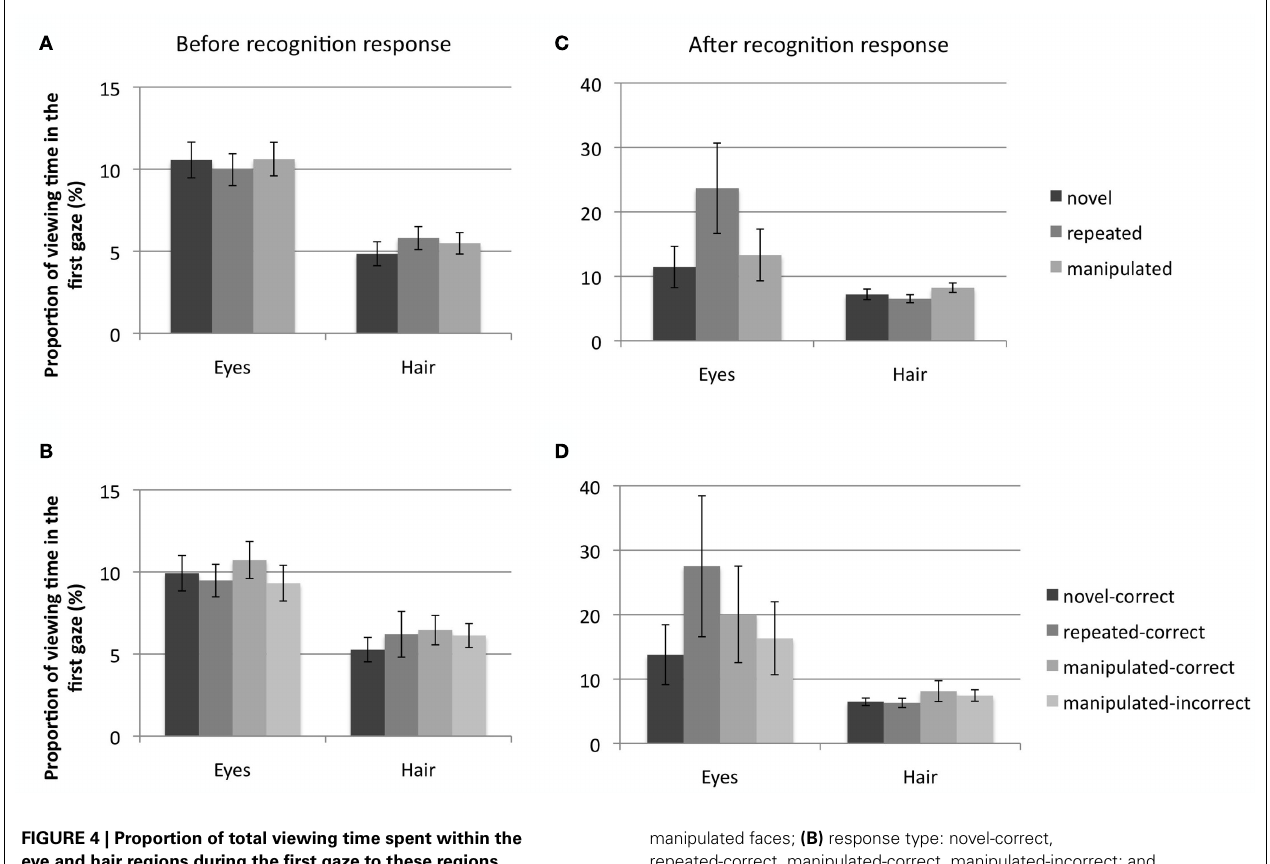
FIGURE 4 | Proportion of total viewing time spent within the eye and hair regions during the first gaze to these regions. Results are shown for when the first gaze ended prior to the recognition response across (A) face type: novel, repeated, and